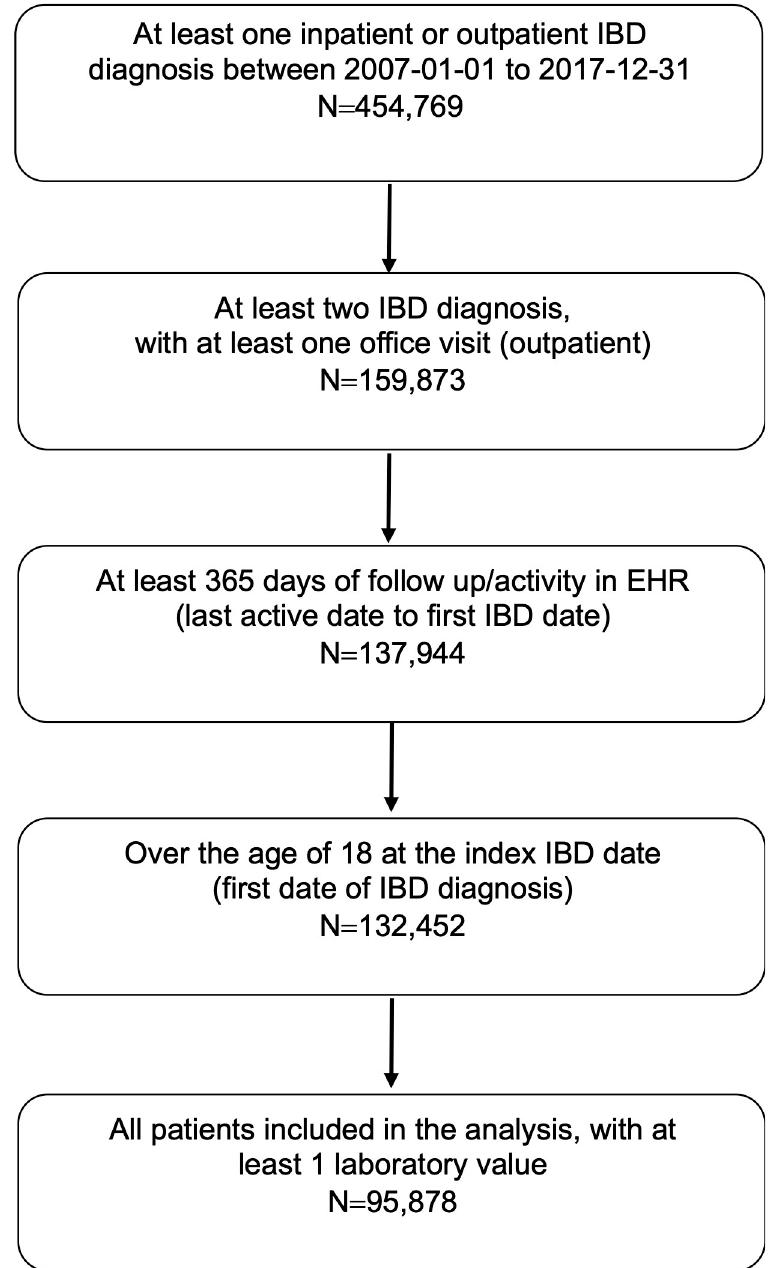
Fig 1. Flow chart of identification of patients with inflammatory bowel disease (IBD) from the Optum electronic health records (EHR) database. past visit mean and maximum, calcium past visit mean, mean corpuscular volume (MCV) at current visit, blood urea nitrogen (BUN) past visit mean, and platelet past visit maximum. TreeSHAP summary plot shows how each of these top 10 variables are influencing the log odds. For example, the variable for the number of previous flares in a patient shows that the log odds increase (positive SHAP value) for higher numbers of previous flares. For the variable of age, the log odds increase (positive SHAP value) for lower age values.